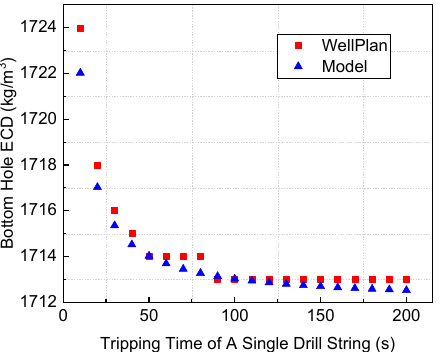
Figure 10. Bottom hole ECD comparison regardless of temperature and joint effects.